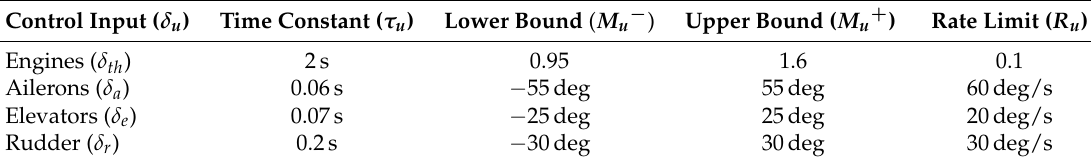
Table A1. Engines & actuators